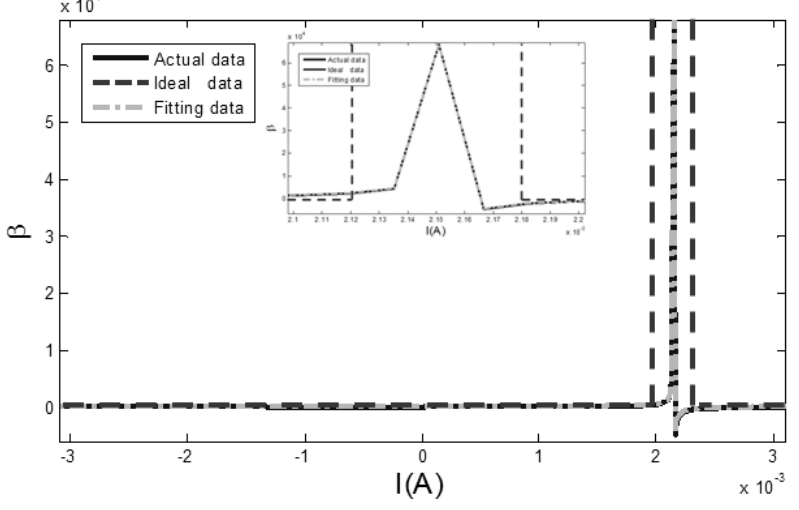
Figure 6. The contrast curve of dynamic permeability